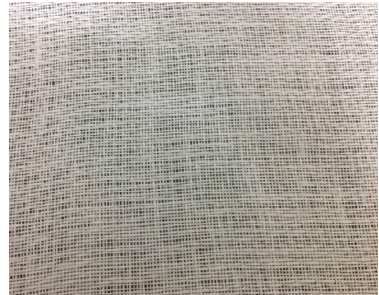
Figure 1. Woven flax fabric.